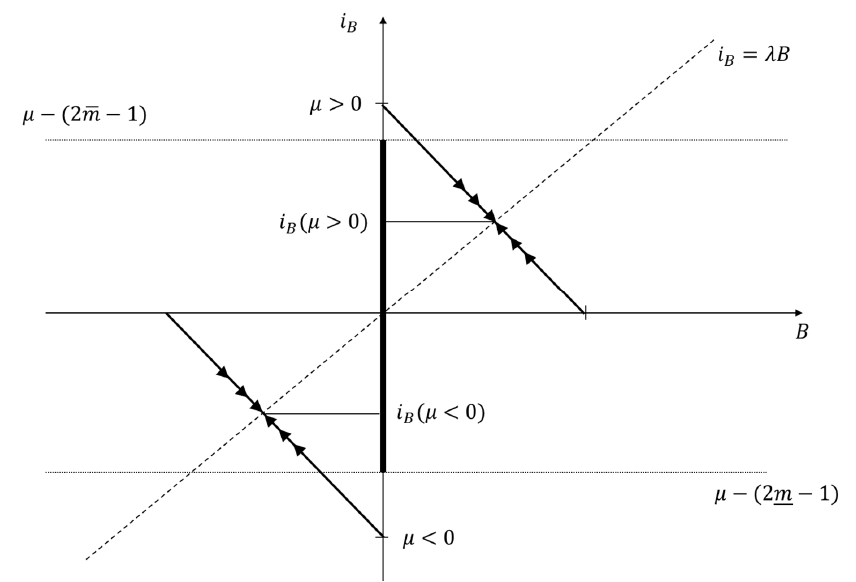
Figure 2. A stable steady state solution.